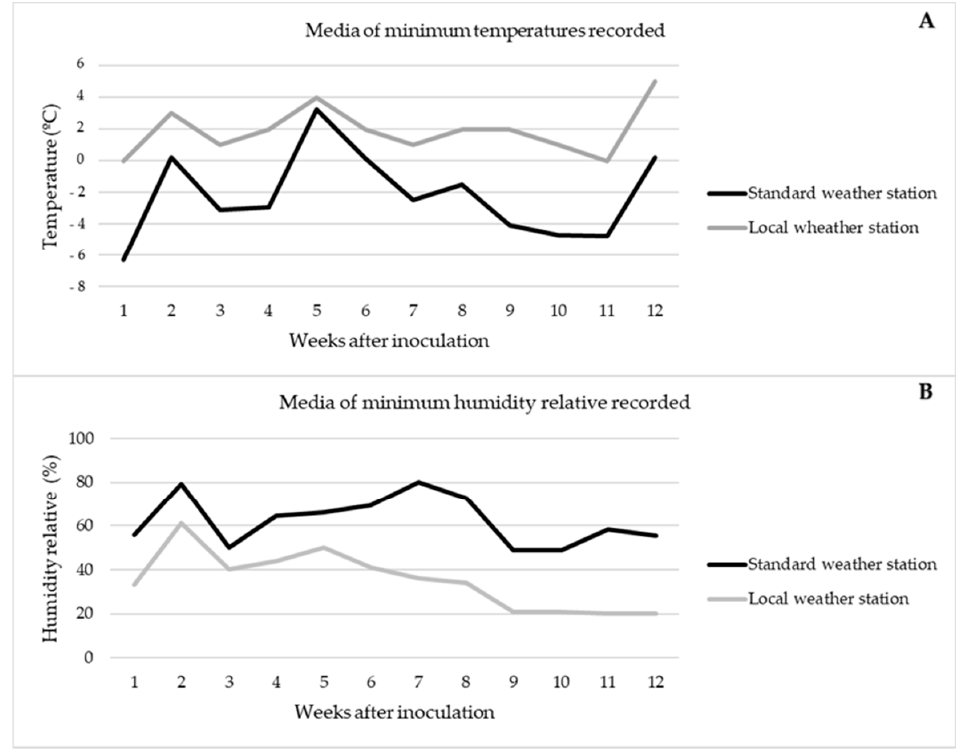
Figure 6. ( A ) Average temperature of each week. ( B ) Average relative humidity of each week.